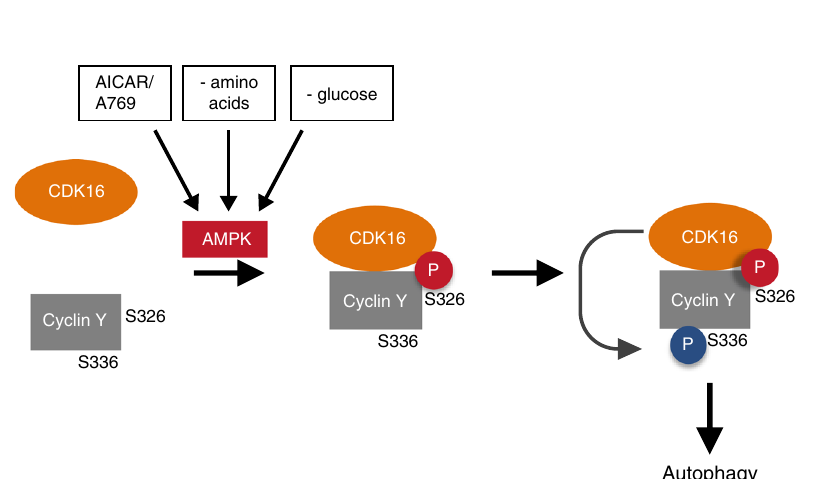
Fig. 7 AMPK-dependent phosphorylation of Cyclin Y at S326 is required for autophagy. a HeLa cells were transfected with GFP-CDK16, Cyclin Y-Flag or phosphosite mutants as indicated. The interaction of CDK16 and Cyclin Y was analyzed in GFP-speci fi c immunoprecipitations (IP). Proteins were analyzed by immunoblotting as speci fi ed (WCL). ( n = 2). b Representative confocal images of HeLa cells from panel a . GFP-CDK16 identi fi ed transfected cells and staining for endogenous LC3 (red, antibody 4E12) monitored autophagy. Scale bar: 50 µ m. c Quanti fi cation of LC3 dots per cell treated as displayed in panel b . Statistical signi fi cance was measured via unpaired and two-tailed Student ’ s t -tests and is presented as follows: ** p < 0.01; *** p < 0.001; **** p < 0.0001. All error bars indicate SD. ( n = 1; 100 cells were analyzed for each treatment; control vs. Cyclin Y/CDK16: t = 7.274, df = 11; control vs. Cyclin Y S324A/ CDK16: t = 4.356, df = 8; Cyclin Y/CDK16 vs. Cyclin Y S100A/CDK16: t = 8.644, df = 13; Cyclin Y/CDK16 vs. Cyclin Y S326A/CDK16: t = 7.765, df = 13; Cyclin Y S100A/CDK16 vs. Cyclin Y S324A/CDK16: t = 5.214, df = 10; Cyclin Y S324A/CDK16 vs. Cyclin Y S326A/CDK16: t = 4.734, df = 10). d HeLa cells were transfected with GFP-CDK16 and Cyclin Y-Flag-wt or the S326A mutant and siRNA against AMPK- α 1/2 or control. The interaction of CDK16 and Cyclin Y was analyzed in GFP-speci fi c immunoprecipitations. Proteins were analyzed by immunoblotting as speci fi ed. ( n = 2). e Representative confocal images of the HeLa cells from panel d . GFP-CDK16 identi fi ed the transfected cells and staining for endogenous LC3 (red, antibody 4E12) measured autophagy. Scale bar: 50 µ m. f Quanti fi cation of the LC3 dots shown in panel e . Statistical signi fi cance was measured via unpaired and two-tailed Student ’ s t -tests and is presented as follows: **** p < 0.0001. All error bars indicate SD. ( n = 1; 250 cells were analyzed for each treatment; siControl vs. siControl Cyclin Y/CDK16: t = 8.113, df = 8; siControl Cyclin Y/CDK16 vs. siAMPK- α 1/2 Cyclin Y/CDK16: t = 8.290, df = 8). n biological independent replicate. SD standard deviation. Source data are provided as a Source Data fi le.